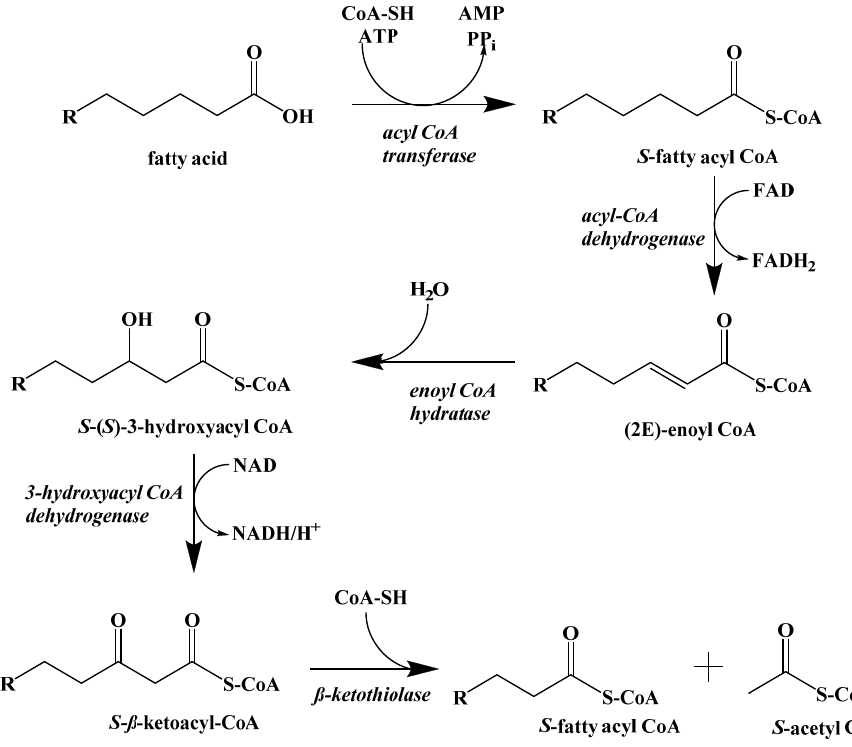
Figure 11. β -Oxidation of a Fatty Acid.